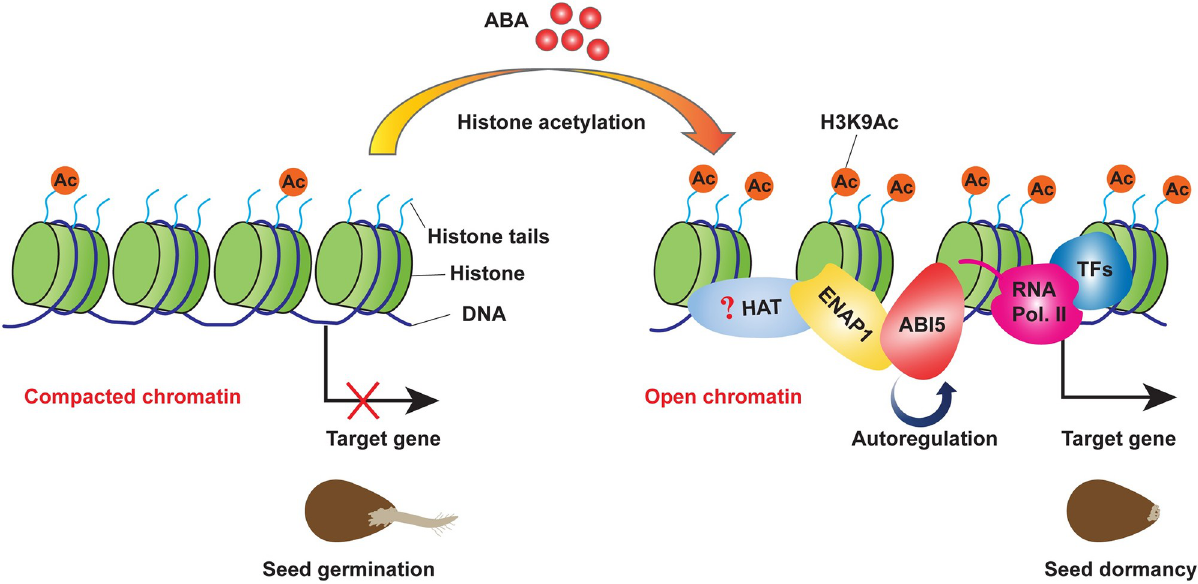
Fig 7. A model to illustrate how ENAP1 inhibits seed germination via H3K9Ac-mediated positive feedback regulation of ABI5 . ENAP1 serves as a chromatin seat taker to keep a higher level of H3K9Ac, leading to a permissive chromatin status for target genes transcription. When there is a higher level of ABA, accumulated ABI5 prefers binding to the loci where ENAP1 binds with a higher level of H3K9Ac, and the interaction between ENAP1 and ABI5 in turn promotes the elevation of H3K9Ac and recruitment of ABI5, leading to an ABI5-dependent positive feedback regulation of the target genes including ABI5 itself, resulting in an inhibition of seed